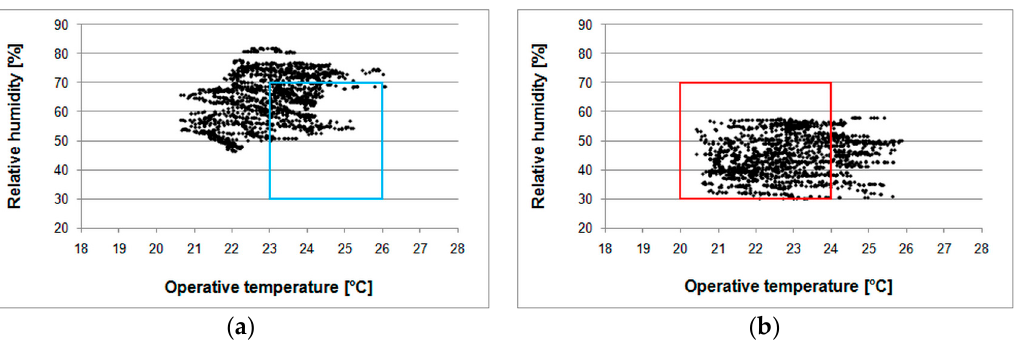
Figure 20. Operative temperature and air humidity against thermal comfort zones of EN ISO 7730: ( a ) for the cooling period (blue border); ( b ) for the heating period (red border).